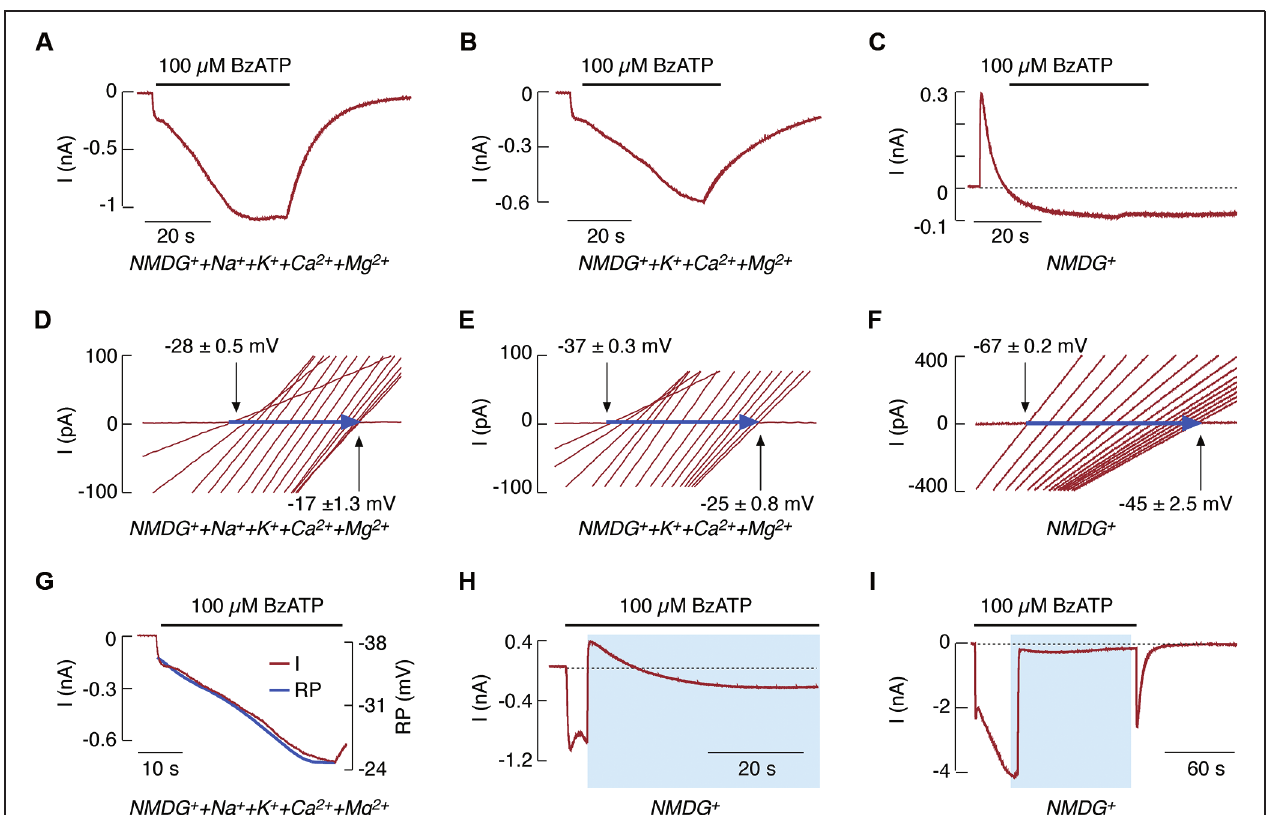
100) for the current-voltage relationship with equal time intervals are shown. ( G ) Comparison of the kinetics of secondary current growth (red trace) and of changes in reversal potential (RP; blue trace) in cells bathed in media containing NMDG + and divalent cations during the 40 s application of BzATP. ( H and I ) 100 µ M BzATP-induced current profiles in cells bathed in a normal physiological solution for 4 s (H) and 40 s (I) , and in NMDG + -containing media for the rest of the agonist application time. Horizontal black lines above the traces indicate the duration of BzATP application, and blue areas indicate the duration of NMDG + application. Derived from Yan et al. (2008,